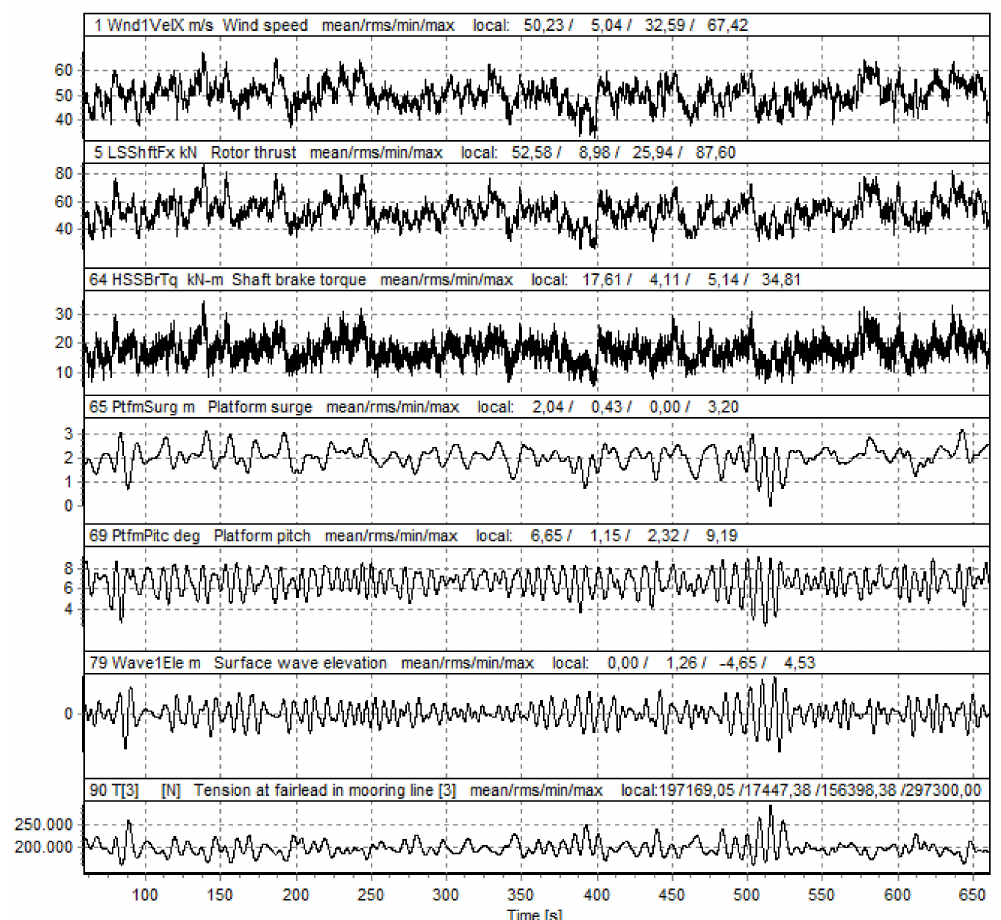
Figure 10. Time history of extreme pitch motion in simulation number 18 of DLC 6.1.